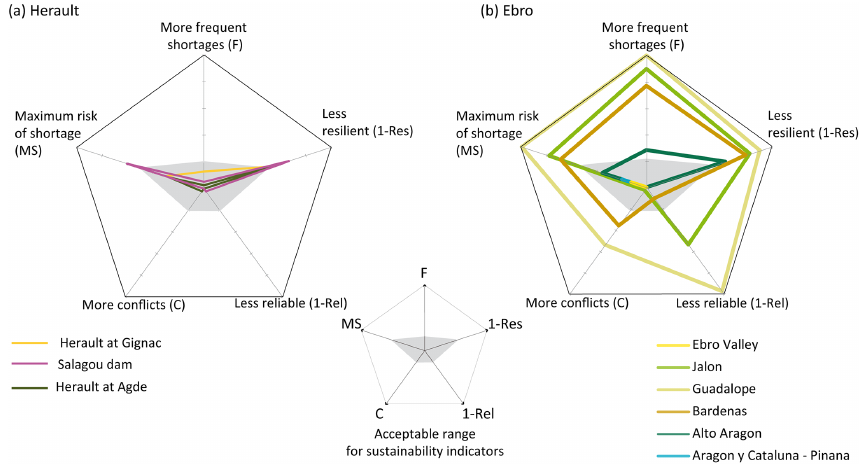
Figure 12. Sustainability of current water uses (2009) under the hydro-climatic conditions of the recent past (1971–2009) for (a) the Hérault and (b) the Ebro basins: frequency of agricultural water shortage ( F ) and of water use conflicts ( C ) in years out of 5 years, resilience (Res), maximum agricultural water shortage (MS), and reliability (Rel) at the main demand nodes of each catchment. Only demand nodes with at least one non-null indicator value are represented in the radar